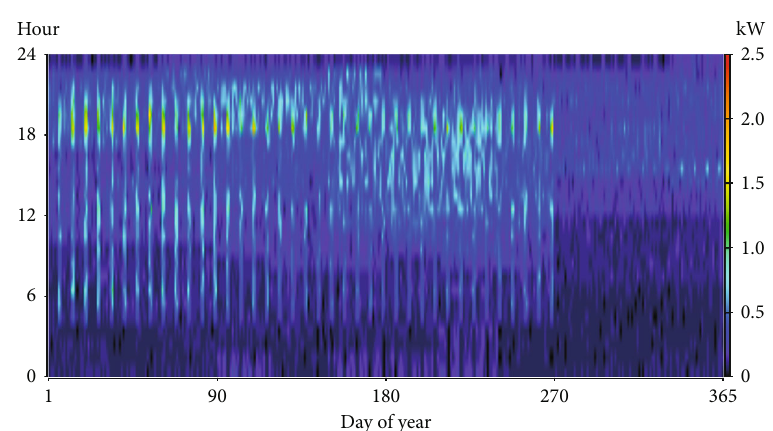
Figure 2: The load assumed to be required by the house in Yazd in an hourly basis [34].